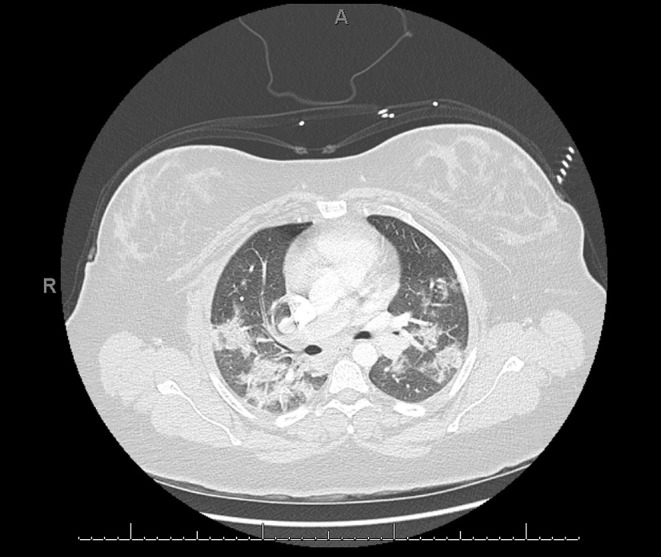
COVID-19 positive patient chest computed tomography (CT). This figure is original and illustrates the findings from (76). It demonstrates bilateral, predominately peripheral, patchy ground-glass opacities consistent with multi-lobar pneumonia.